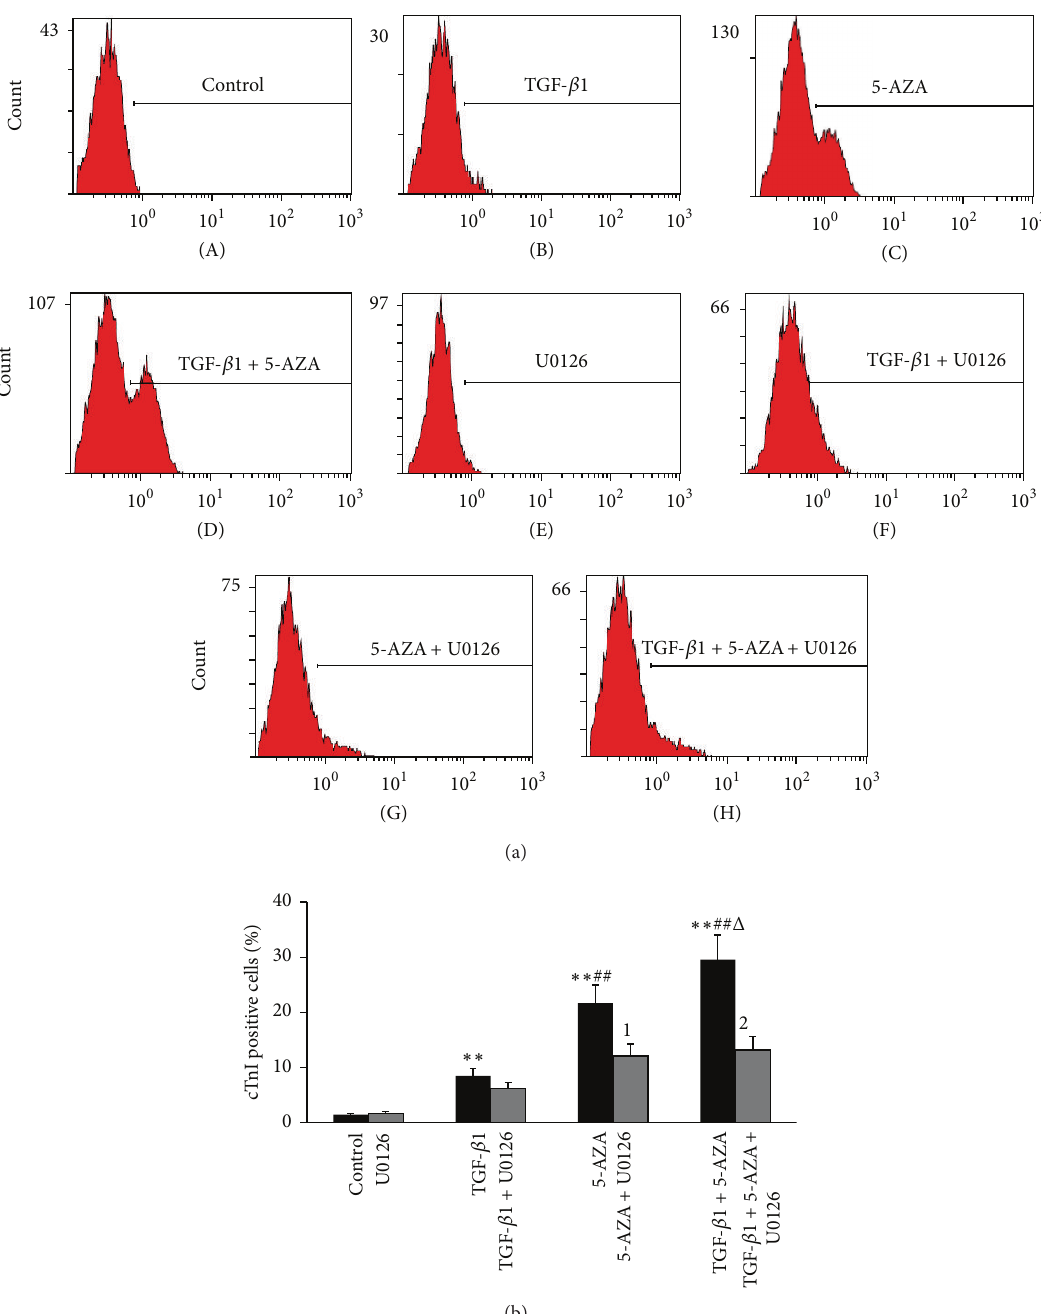
Figure 5: Flow cytometric analysis of differentiation potential of BMMSCs. (a) Graph showing the proportion of positive cells after staining with the cTnI in the different treatment groups and uninduced groups. (b) Histograms showing the proportion of positive cells after staining with the cTnI in treated and uninduced BMMSCs. Results are expressed as the means ± SEM. ∗∗ 𝑃 < 0.01 versus control group; ## 𝑃 < 0.01 versus TGF- 𝛽 1 group; Δ 𝑃 < 0.05 versus 5-AZA group; 1 𝑃 < 0.05 versus 5-AZA group; 2 𝑃 < 0.01 versus combined treatment group ( 𝑛 = 3 ).